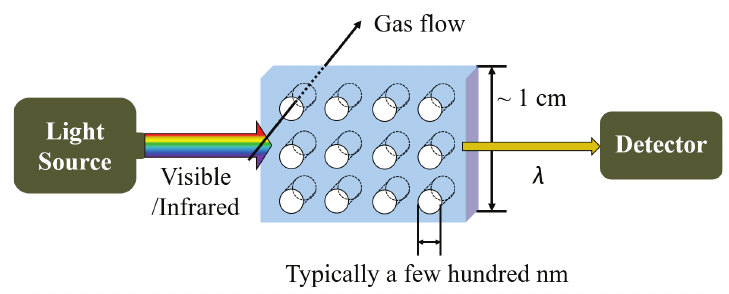
Figure 13. Schematic view of a photonic crystal gas sensor. Photonic crystal (PhC) with periodic micro- or nano-patterns are placed between light source and photo detector. Gaseous analytes can pass through the patterns or be condensed in the patterns where they change the effective refractive index, n , or the lattice distance of periodic structure, d . The diffraction wavelength changed by the two factors is detected by the detector based on Bragg’s